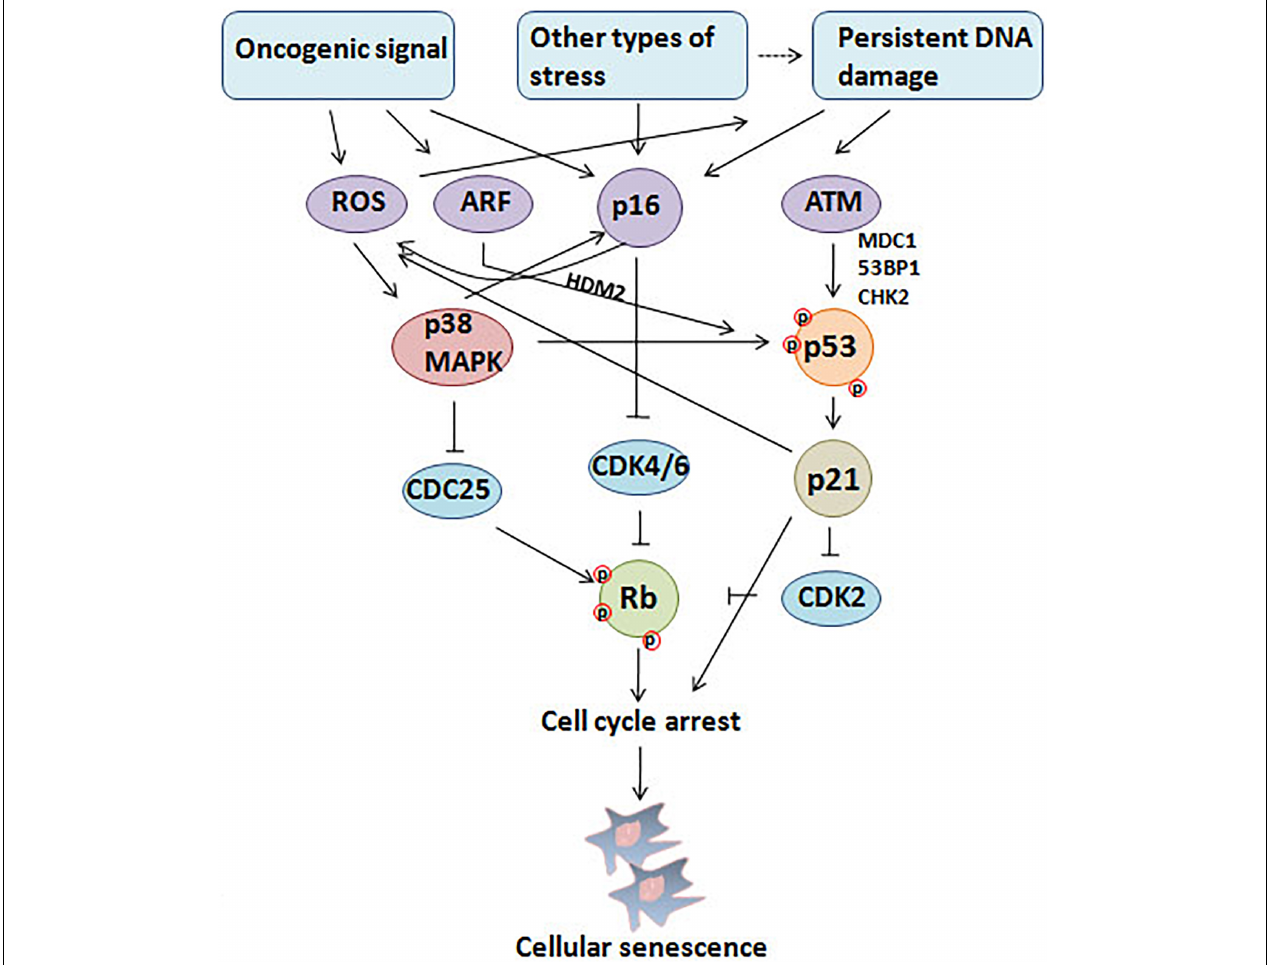
FIGURE 1 | Triggers and main effector pathways of senescence. Persistent DNA damage induced by diverse stimuli and abnormal oncogenic signal lead to senescence mainly by regulating p16INK4a–pRb and p53/p21